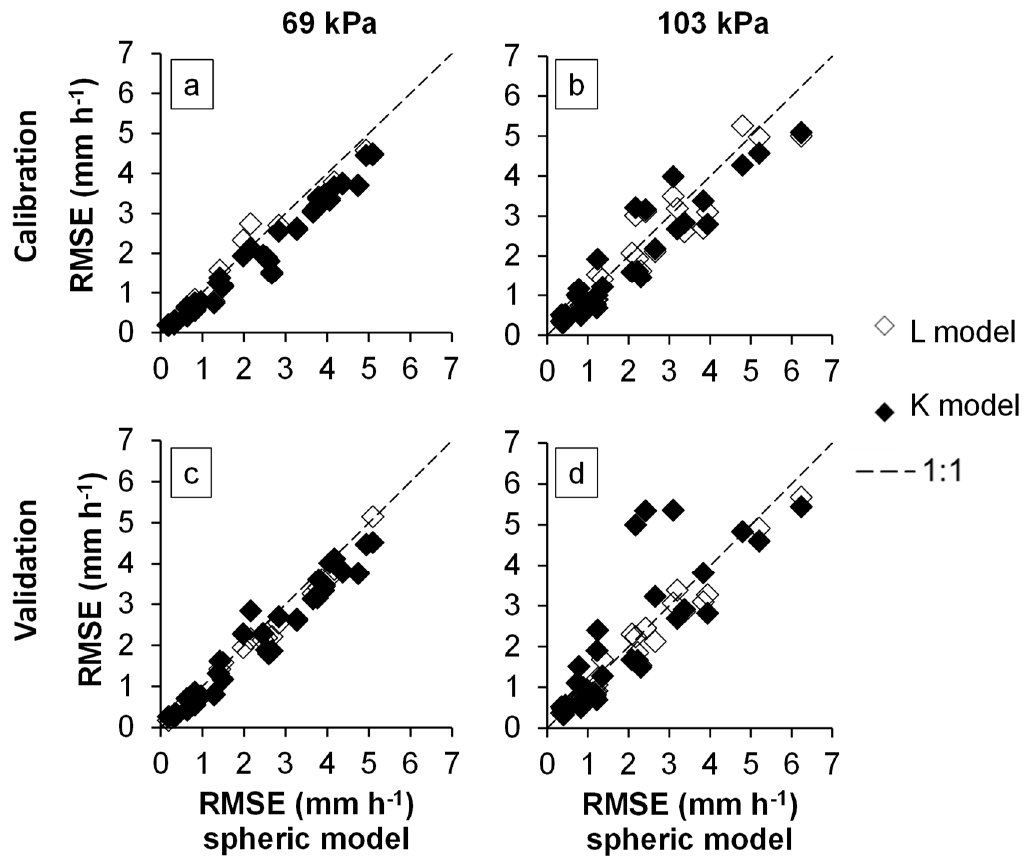
Figure 9. RMSE comparisons of the calibration ( a , b ) and validation ( c , d ) phases for the operating pressures of 69 kPa and 103 kPa. RMSE of the Fukui et al. [20] drag model vs. RMSE of the L model and Tarjuelo et al. [21] drag model for both pressures are shown in each figure. Each model is shown with a different symbol. The 1:1 relationship is represented with a dashed line.